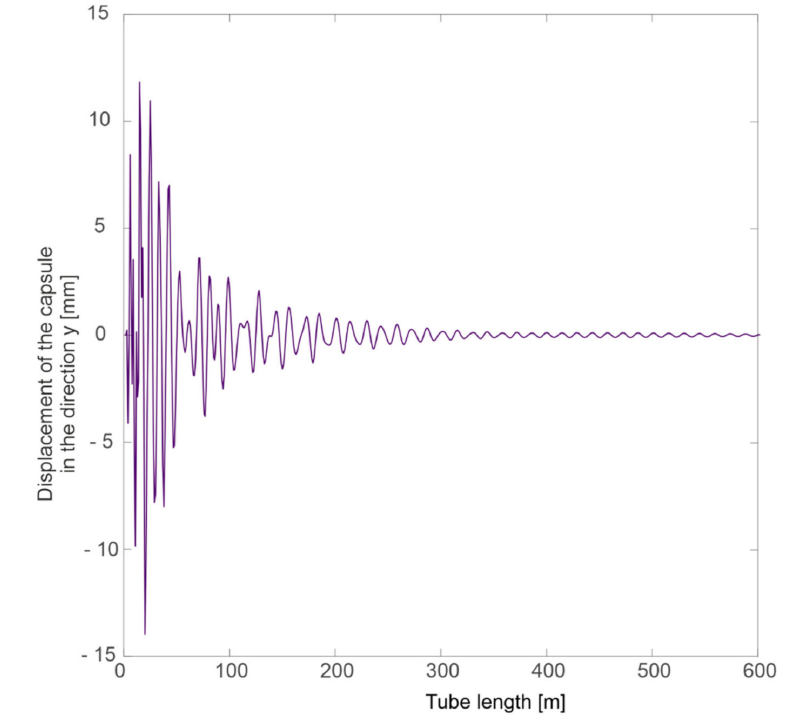
Figure 17. Vertical displacement in direction y of the capsule at a speed of 2000 km /